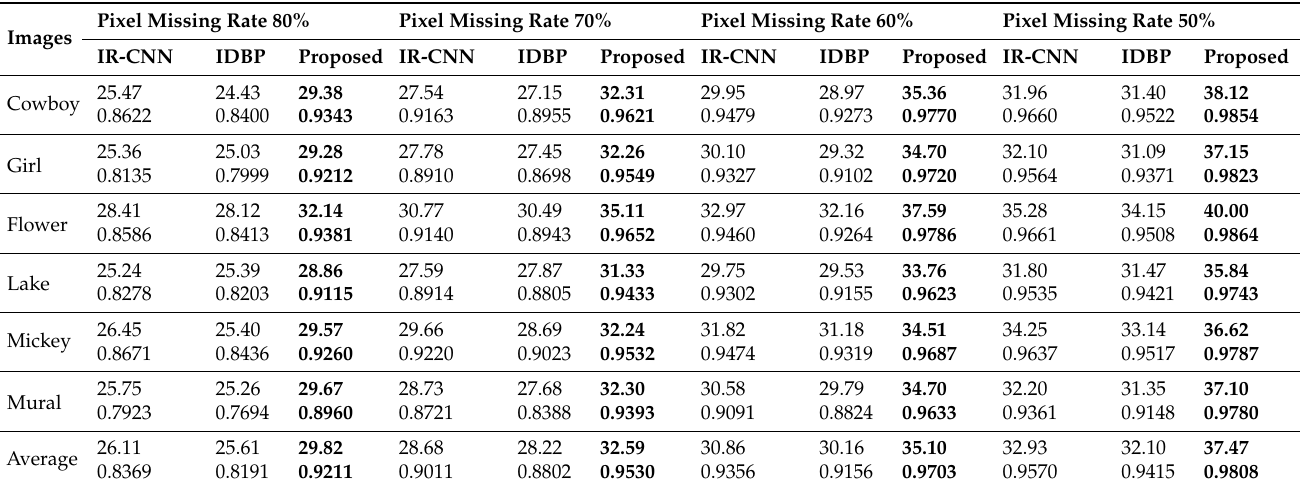
Table 3. PSNR and SSIM values of the proposed method and two deep-learning-based methods with four different pixel missing